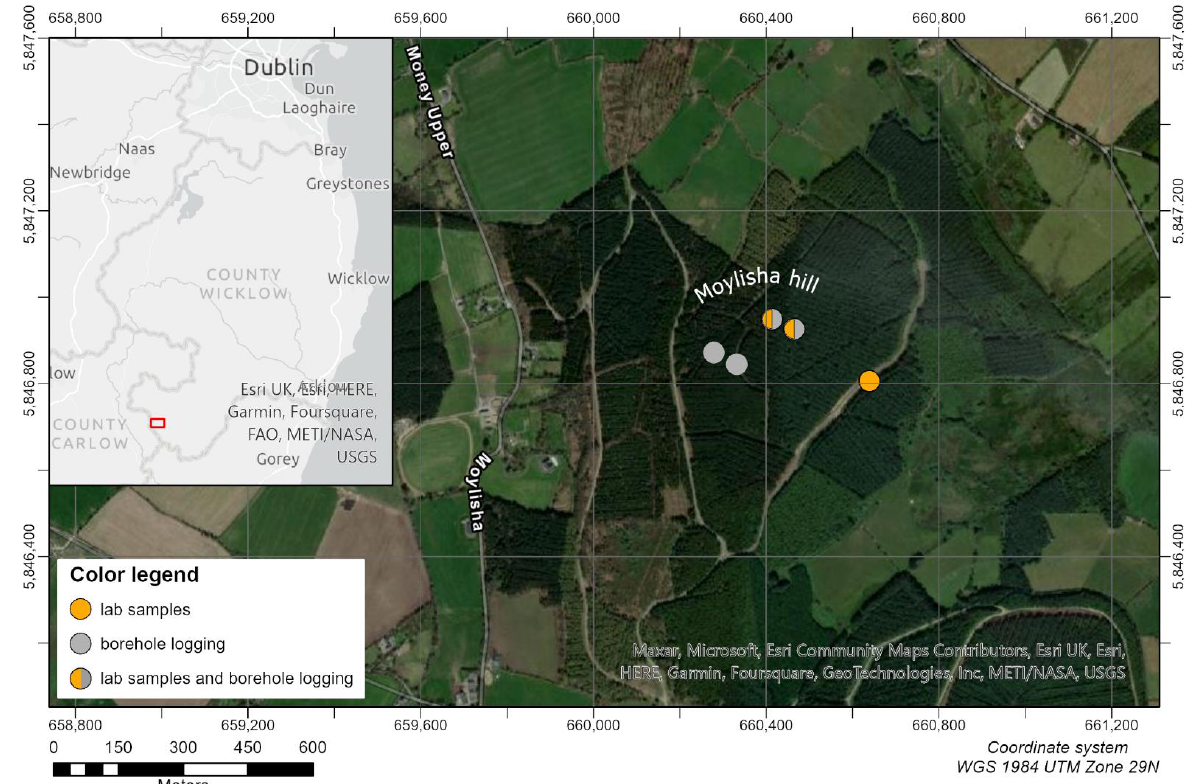
Figure 4. Location map with the sample sites in South Leinster (Ireland). All locations are borehole sites. The red frame in the inset map outlines the location map.